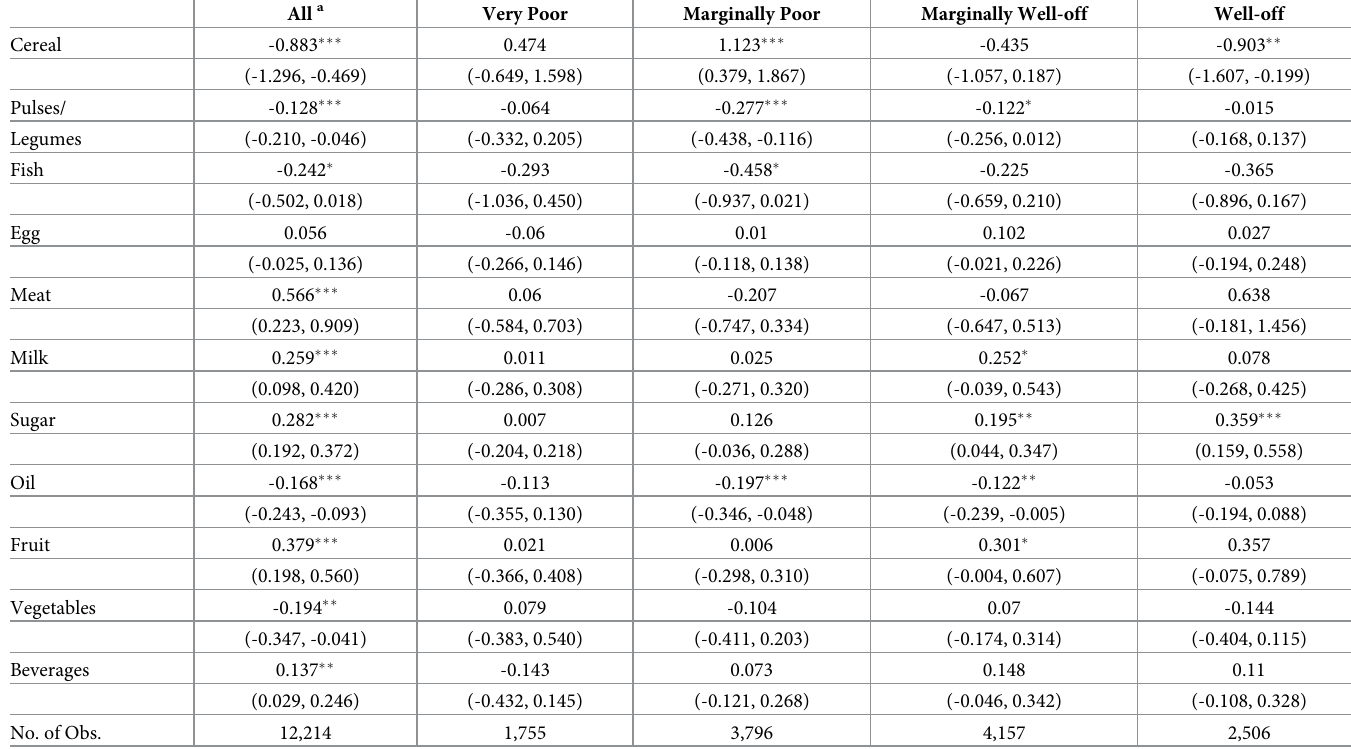
Table 7. Adjusted differences in food expenditure categories between NCD and non-NCD